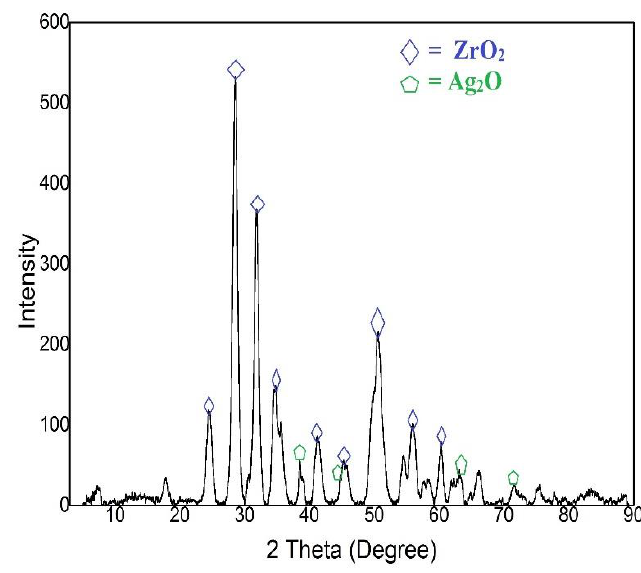
Figure 1. Powder X-ray diffractogram of 2.5% Ag 2 O – ZrO 2 catalyst.